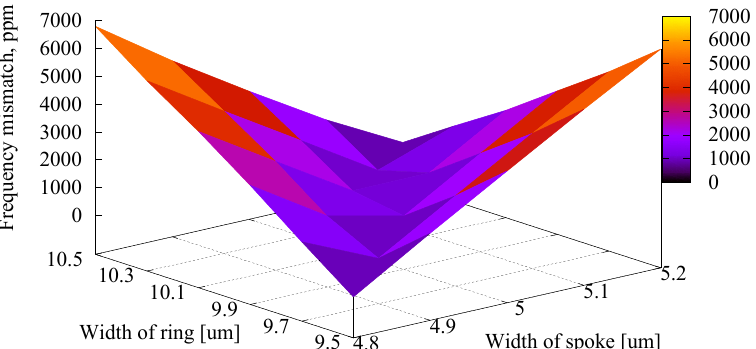
Figure 8. Frequency mismatch between two resonant modes (in the optimized design) under different ring width and spoke width error.